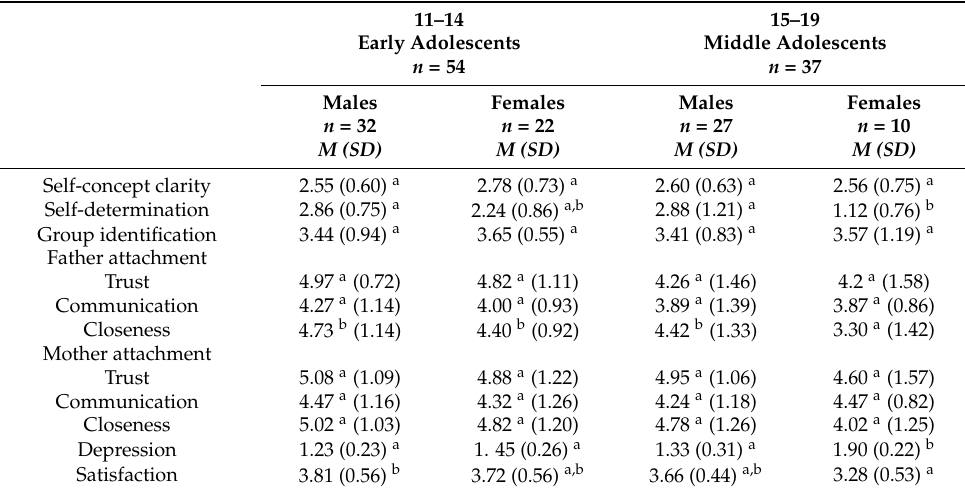
Table 2. Mean scores of Self-concept clarity, Self-determination, Group identification, Parents’ attach- ment, Depression and Satisfaction in function of gender and